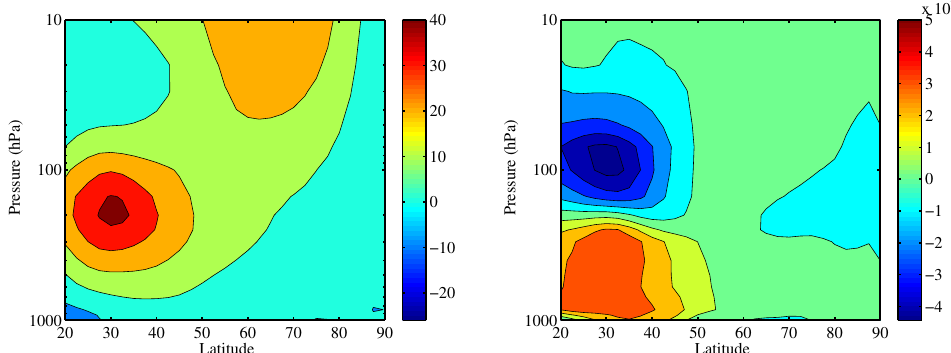
Figure 1. Climatology of the zonal mean zonal wind (left) in and the vertical shear of zonal mean zonal wind (right) for the Northern Hemisphere during DJF. The units are ms − 1 for zonal mean zonal wind and ms − 1 km − 1 for the vertical shear of zonal mean zonal wind